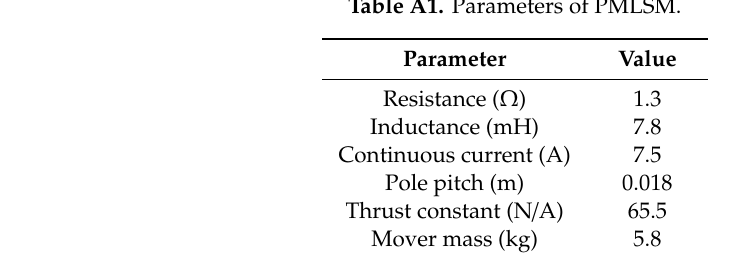
Table A1. Parameters of